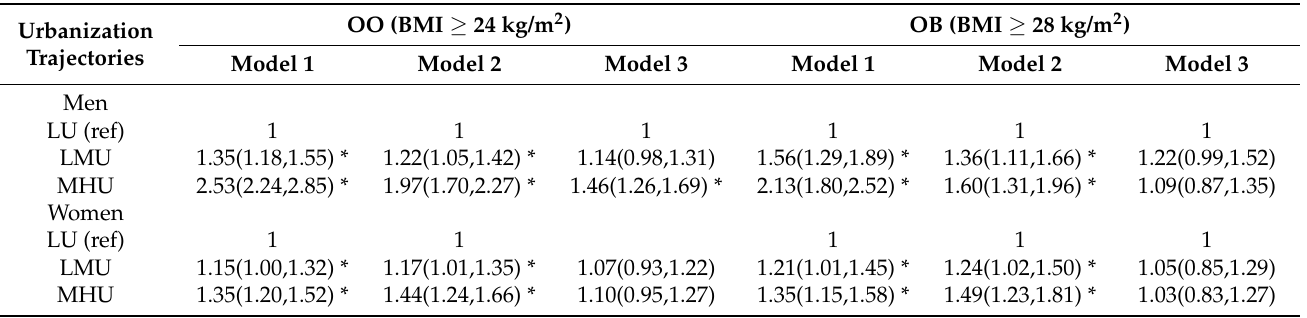
Table 3. Multilevel mixed regression analysis of associations between urbanization trajectories and risk of obesity by